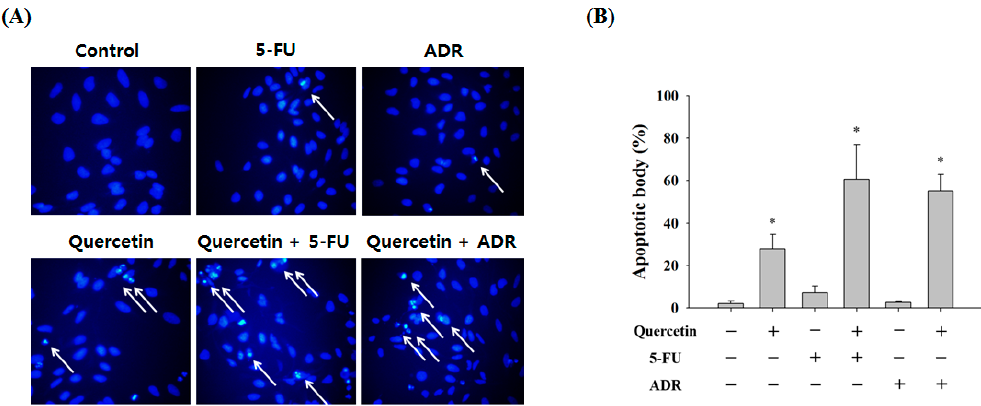
Figure 6. Effect of combining quercetin with 5-FU or ADR on the induction of apoptosis in AGS-cyr61 cells. ( A ) Synergistic effects of quercetin and 5-FU and ADR on apoptosis in AGS-cyr61 cells for 24 h. AGS-cyr61 cells were treated with 25 μ M quercetin, 25 μ M 5-FU, and 125 nM ADR. Treatment was given as one drug alone or as a combination of drugs. Apoptotic bodies were determined using Hoechst 33342 staining, and stained cells were visualized under a fluorescence microscope; ( B ) Number of apoptotic bodies. Data are the means ± standard error for one experiment performed in triplicate. * p < 0.05 compared with the control.